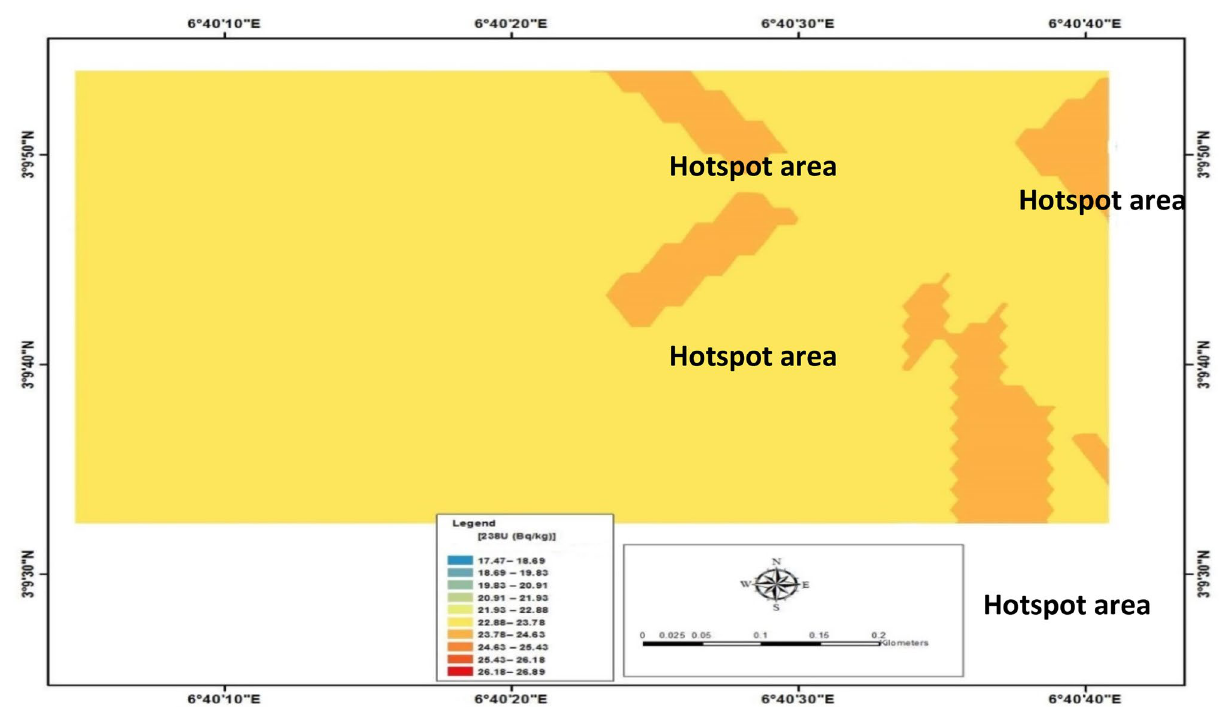
Figure 3. Showing the distribution pattern of Uranium-238 in the study